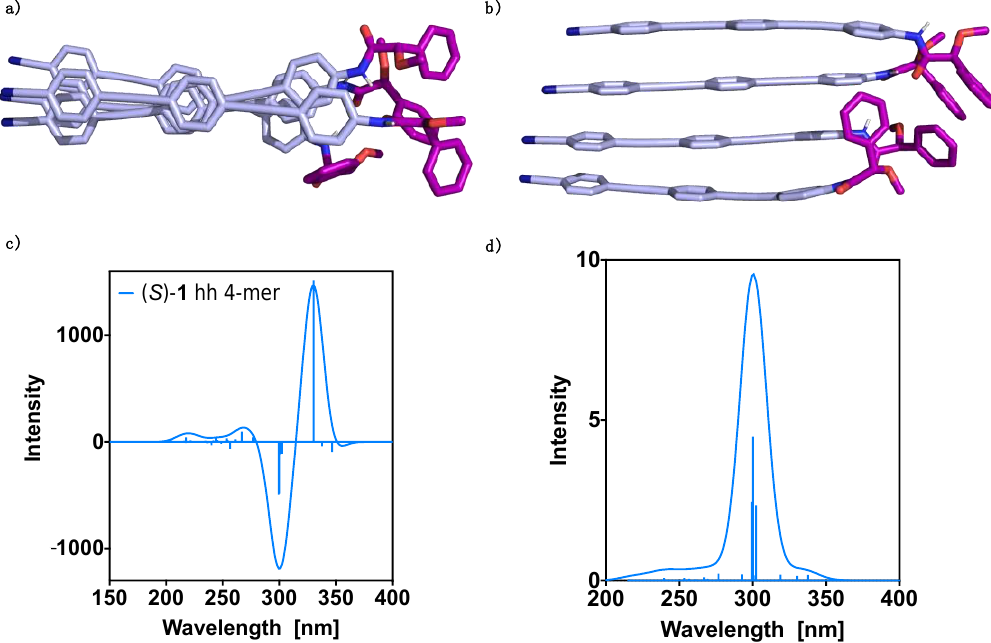
Figure 4. Oligo(phenyleneethynylene) (OPE) ( S )- 1 hh 4-mer DFT(B3LYP-D3)/6–31G** optimized structure: ( a ) perpendicular view and ( b ) parallel view. TD-DFT (CAM-B3LYP)/3–21G spectra evaluated at the DFT(B3LYP-D3)/6–31G** optimized geometry: ( c ) ECD and ( d ) UV-Vis. No correction factors are included in the theoretical wavelengths.